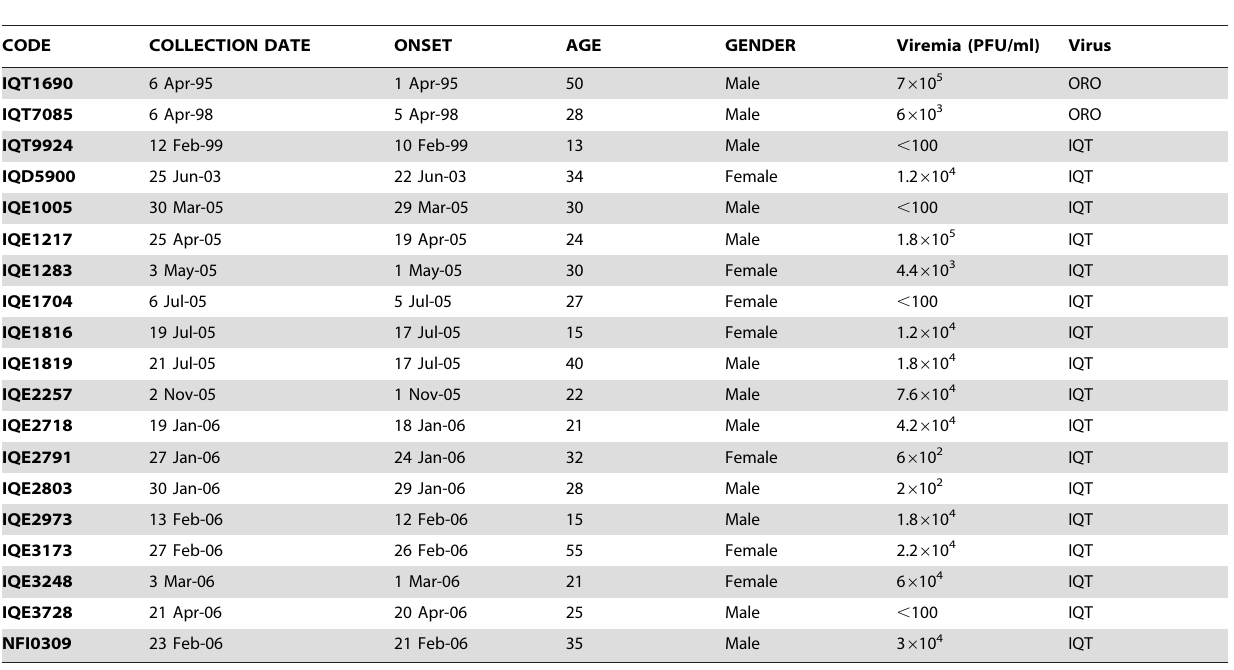
Table 1. Viremia titer for human febrile cases in Iquitos, Peru, included in the study.